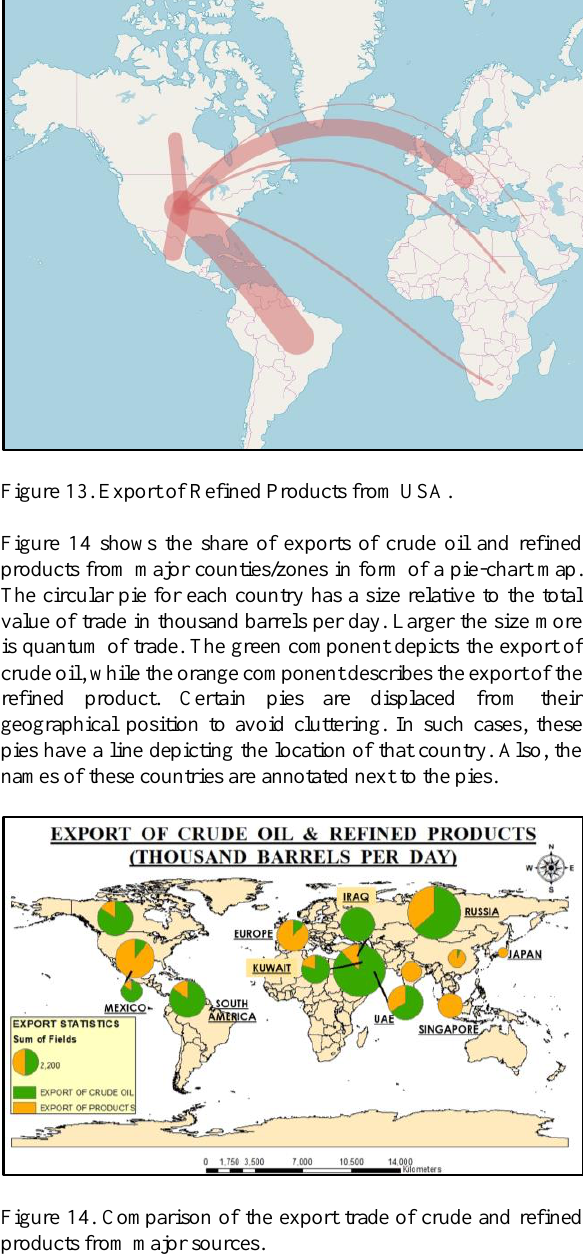
Figure 14. Comparison of the export trade of crude and refined products from major sources.